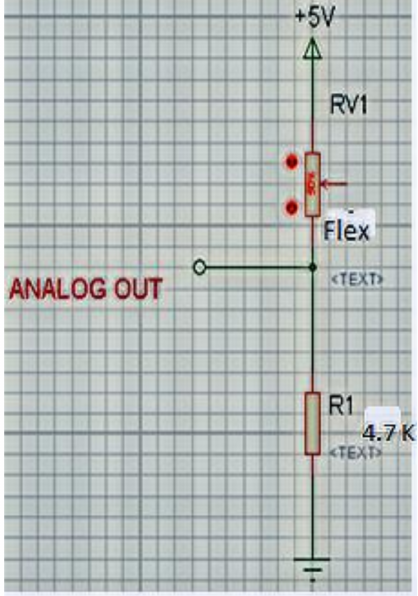
Figure 6. Arrangement for reading the flex